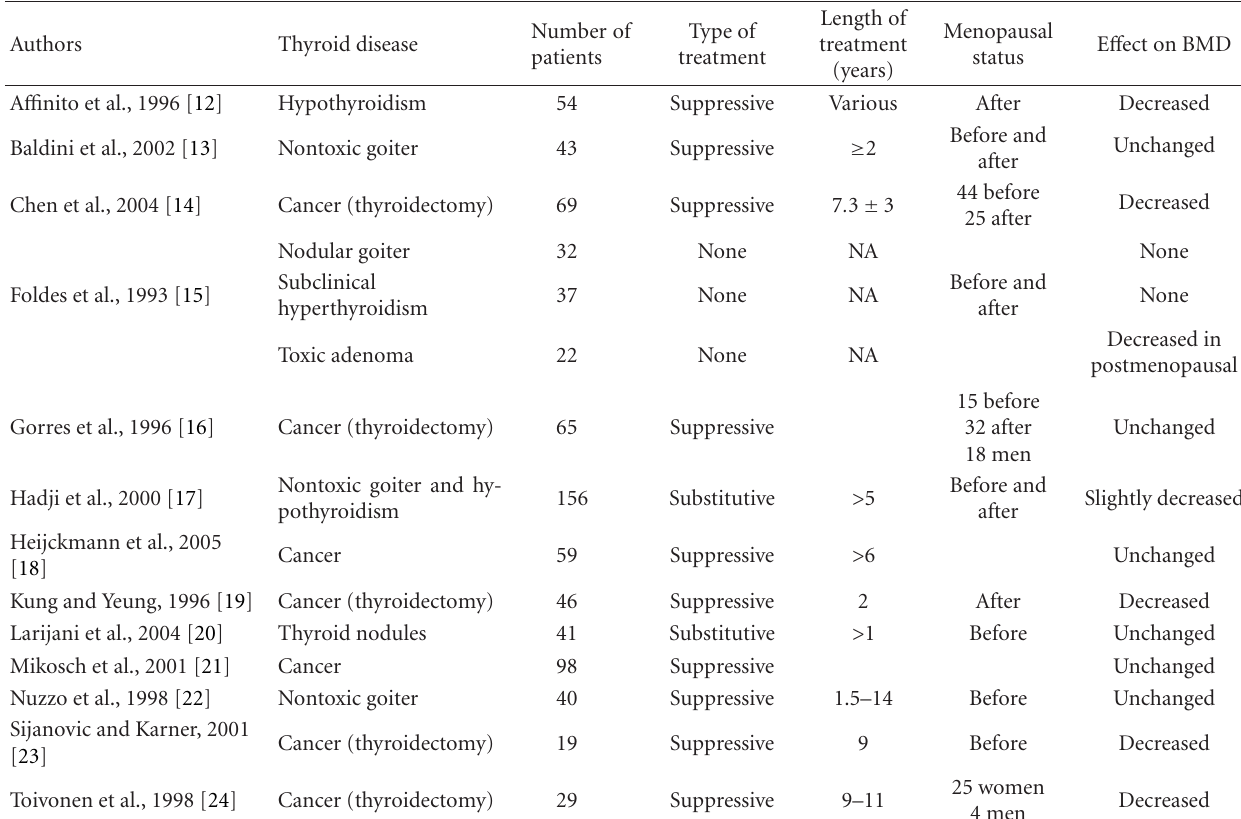
Table 4: Summary of the principal characteristics of the main studies exploring the e ff ects of the treatment with L-thyroxin on the bone mineral density